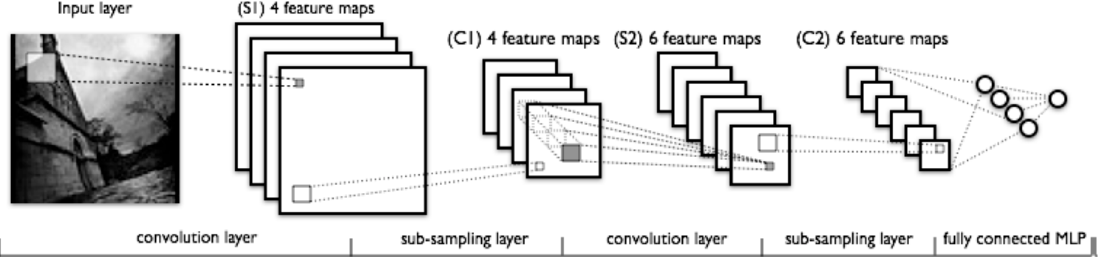
Figure 4. Architecture of a Deep Convolutional Neural Network (DCNN), alternating the convolutional layer and the max-pooling layer (or sub-sampling layer), and finally the fully-connected layer [56].